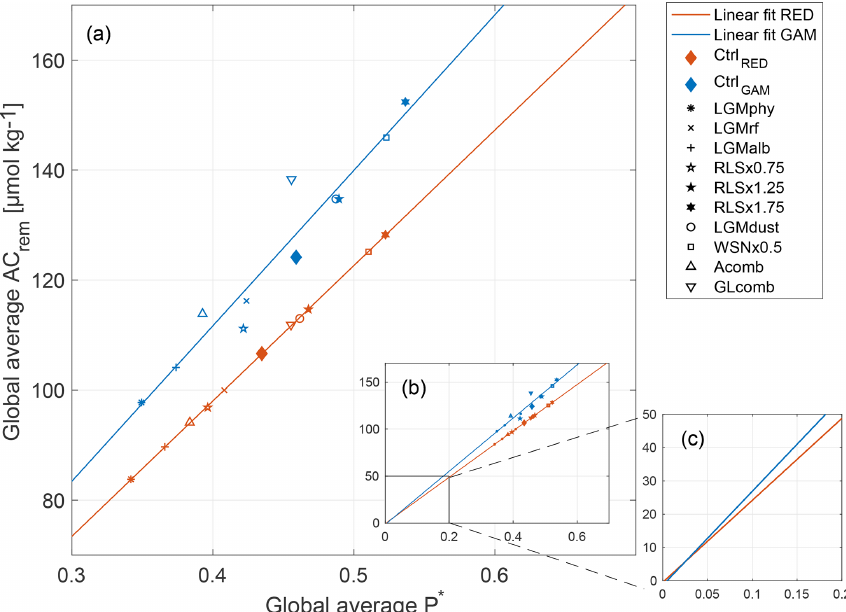
Figure 9. Remineralized acidic carbon (AC rem = DIC rem − ( 1 / 2 ) × ALK rem ; see Appendix A) as a function of P ∗ . Simulations using model versions RED and GAM are shown in red and blue respectively. Different symbols indicate the sensitivity experiments, listed in the panel on the right-hand side. Red and blue lines show linear least-squares fits to the separate ensembles for RED and GAM. Panels illustrate (a) the deviation from the least-squares fit of the GAM ensemble as opposed to the RED ensemble, (b) the linear fits extrapolated to the origin, and (c) a zoom-in around the origin, where the RED (red) line goes through the origin, while the GAM (blue) does